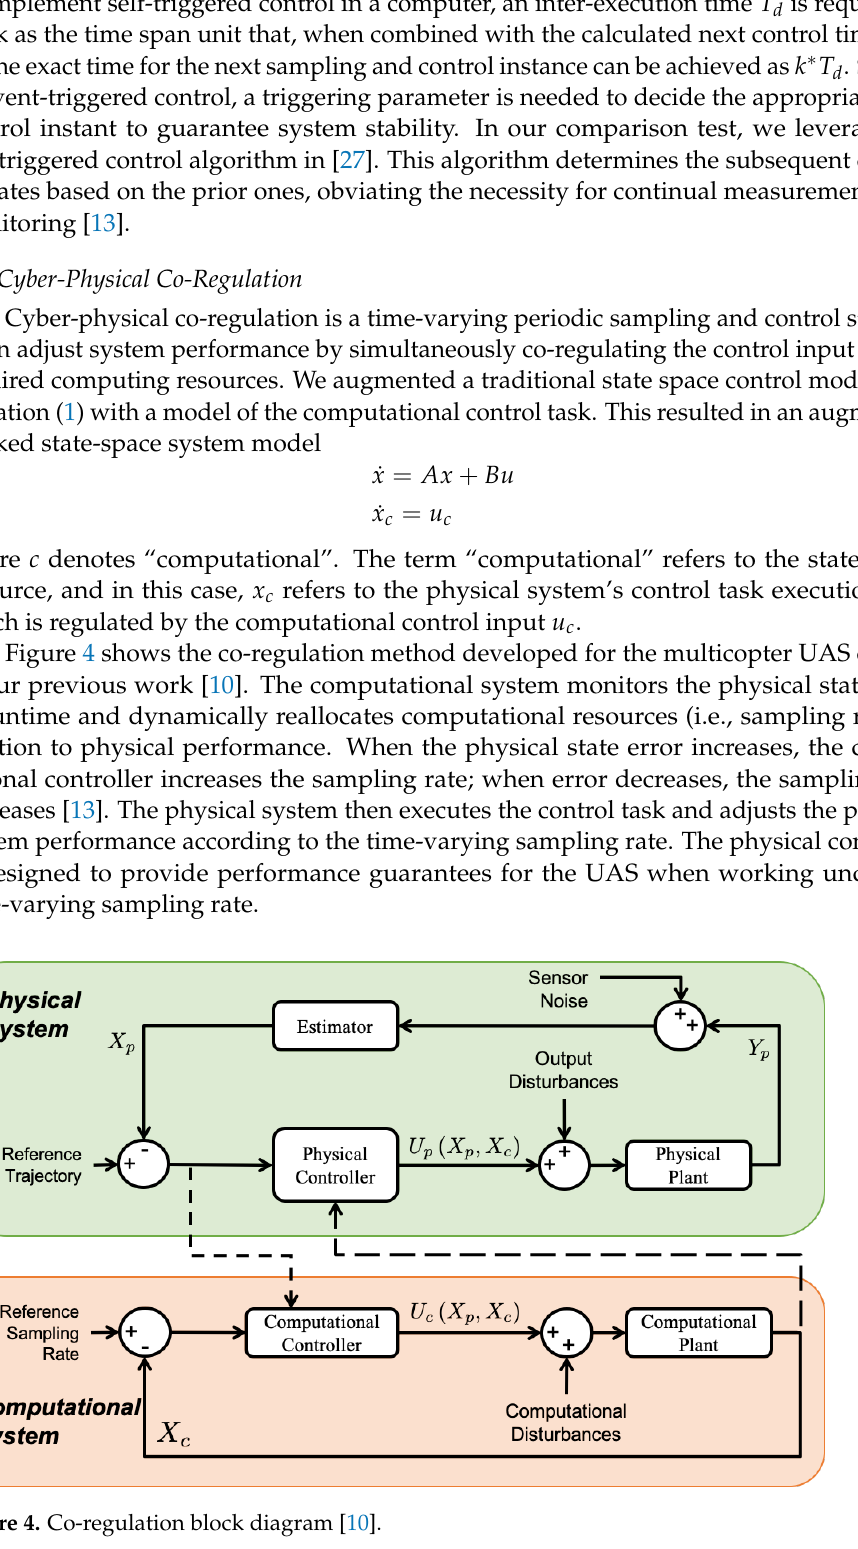
Figure 4. Co-regulation block diagram